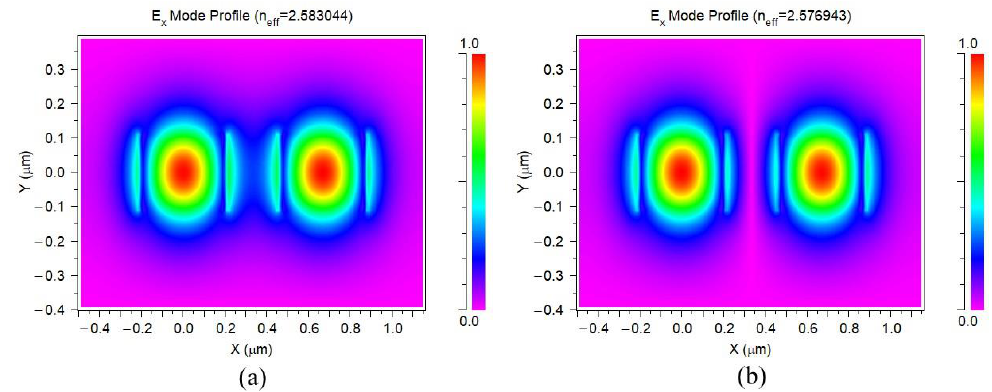
Figure 2. Effective indices simulation for ( a ) symmetrical and ( b ) antisymmetrical supermodes from two coupled straight waveguides.